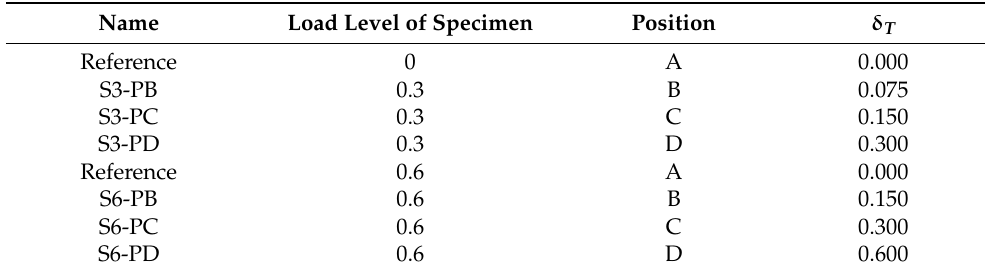
Table 3. Stress level δ T of the tested surface under different loading conditions.